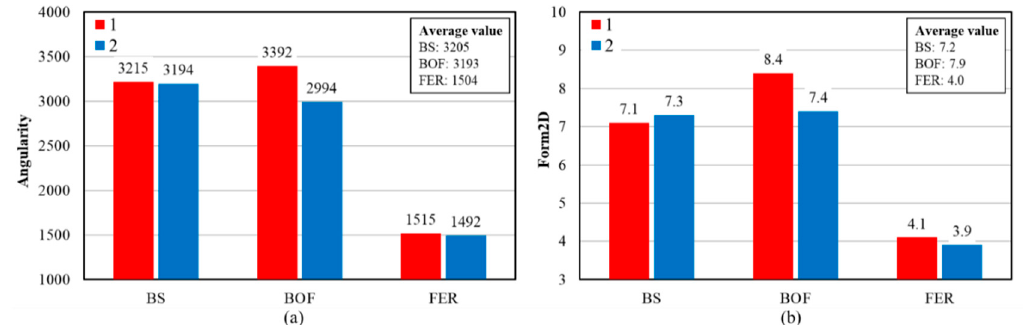
Figure 6. Morphologies of three kinds of aggregates: ( a ) angularity, ( b ) form2D.